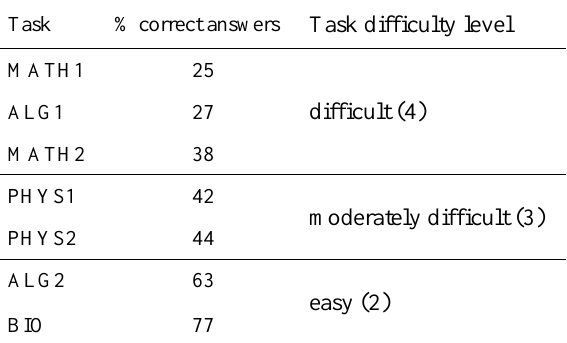
The percentage of the correct answers as a criterion of the task difficulty level